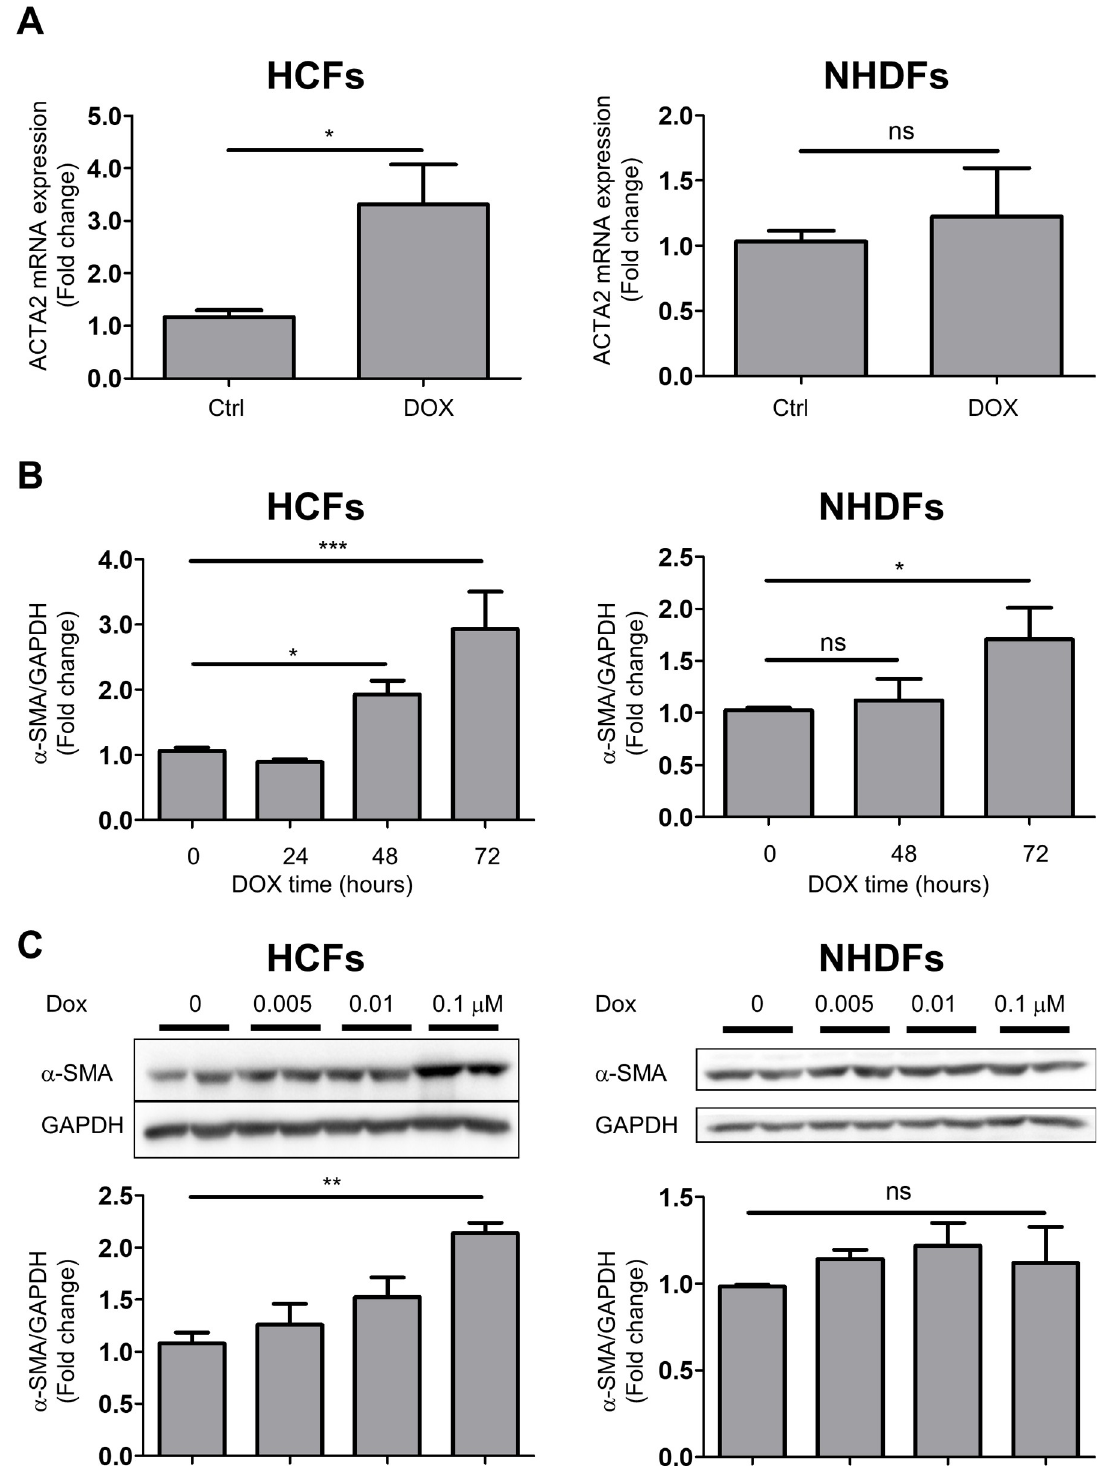
Fig 2. DOX induced trans-differentiation of HCFs but not NHDFs. A, ACTA2 mRNA expression in the presence of DOX for 24 hours in HCFs (left) and NHDFs (right) (n = 5–6; � p < 0.05; ns: no significant difference). B, α -SMA protein expression in the presence of DOX (0.1 μ M) for 24 to 72 hours in HCFs (left) and NHDFs (right) (n = 4–6; �� p < 0.01, and � p < 0.05). C, α -SMA protein expression in the presence of DOX (0.005 to 0.1 μ M) for 48 hours in HCFs (left) and NHDFs (right) (n = 4; �� p < 0.01; ns: no significant difference). The original immunoblot image is shown in S2 Fig.